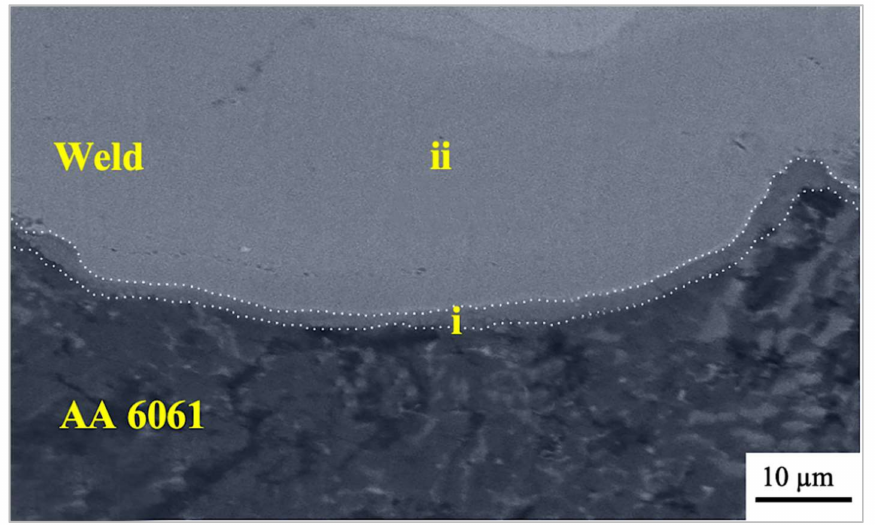
Figure 4. SEM image of weld zone (from area A in Figure 2). i and ii are the areas where EDS